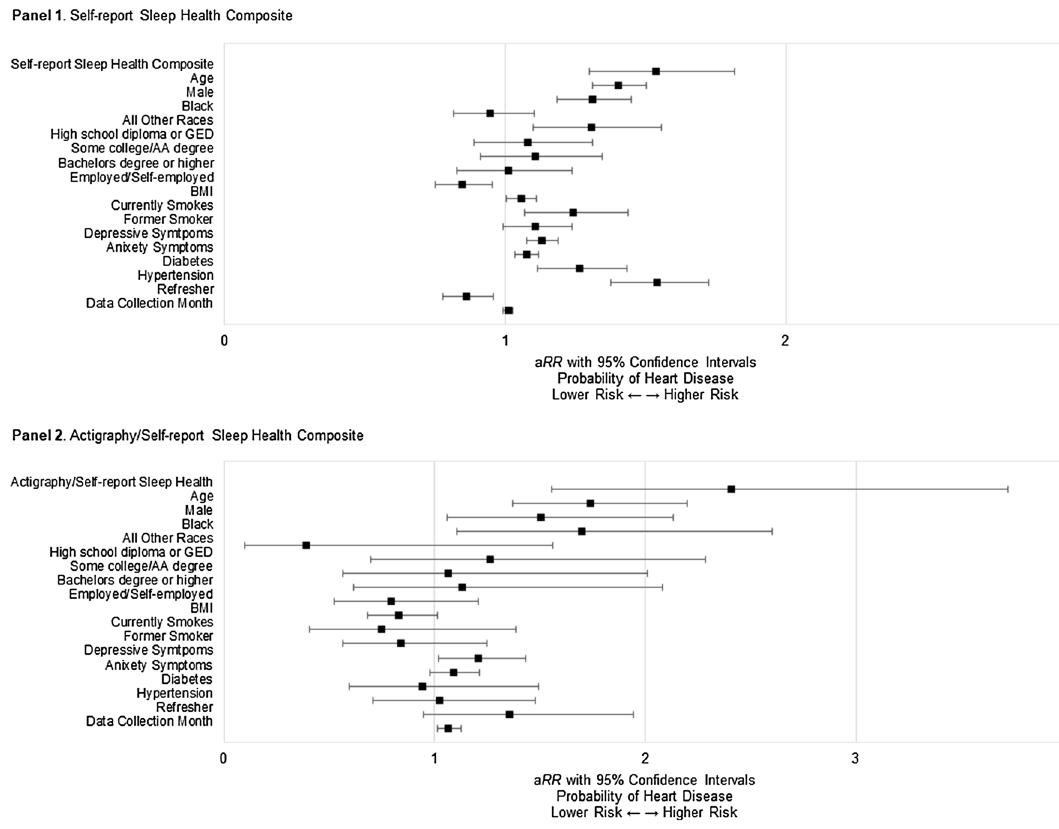
Figure 2. Results of modified Poisson analyses displaying the relative risk of heart disease by the weighted sleep health composites and